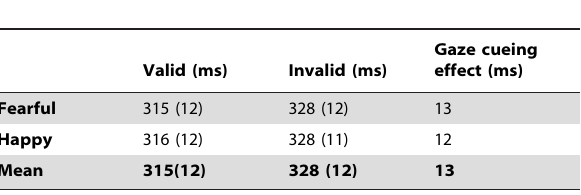
Table 1. Grand mean reaction time (and standard error of the mean) for each emotion and for each cue-target validity